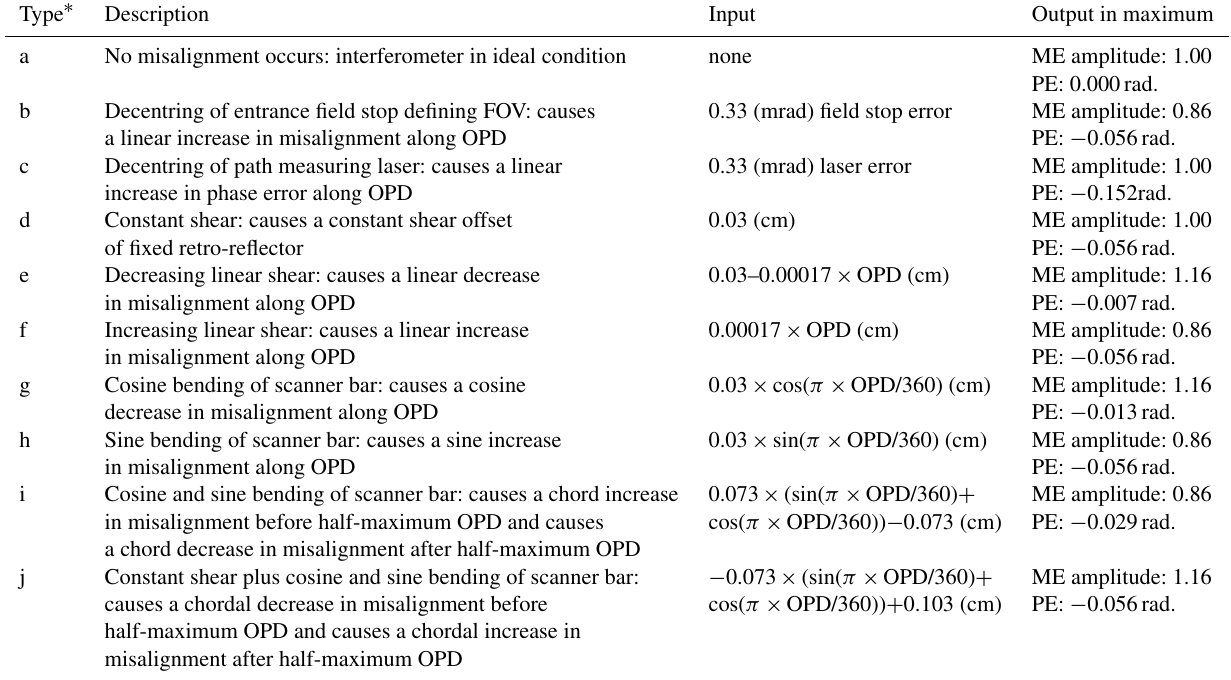
Table 1. Misalignments simulated in the